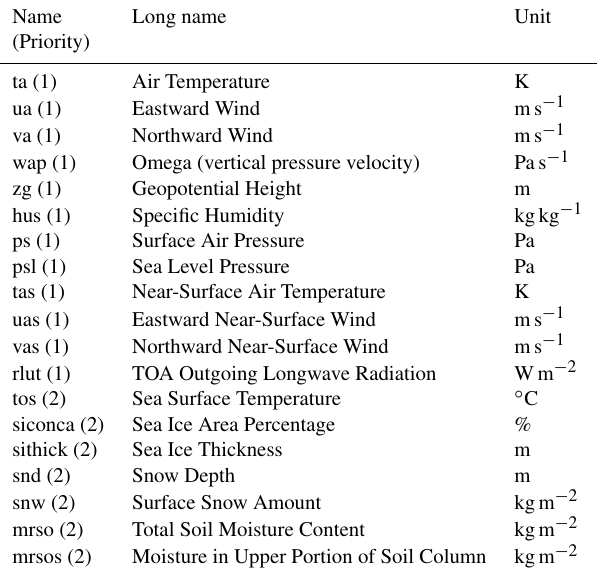
Table 4. Variables in the 6hrPt data table. Instantaneous atmo- spheric (XYPT) and surface (XYT) quantities output at 6h inter- vals. See Sect. 5 for meaning of priority levels. TOA stands for top of